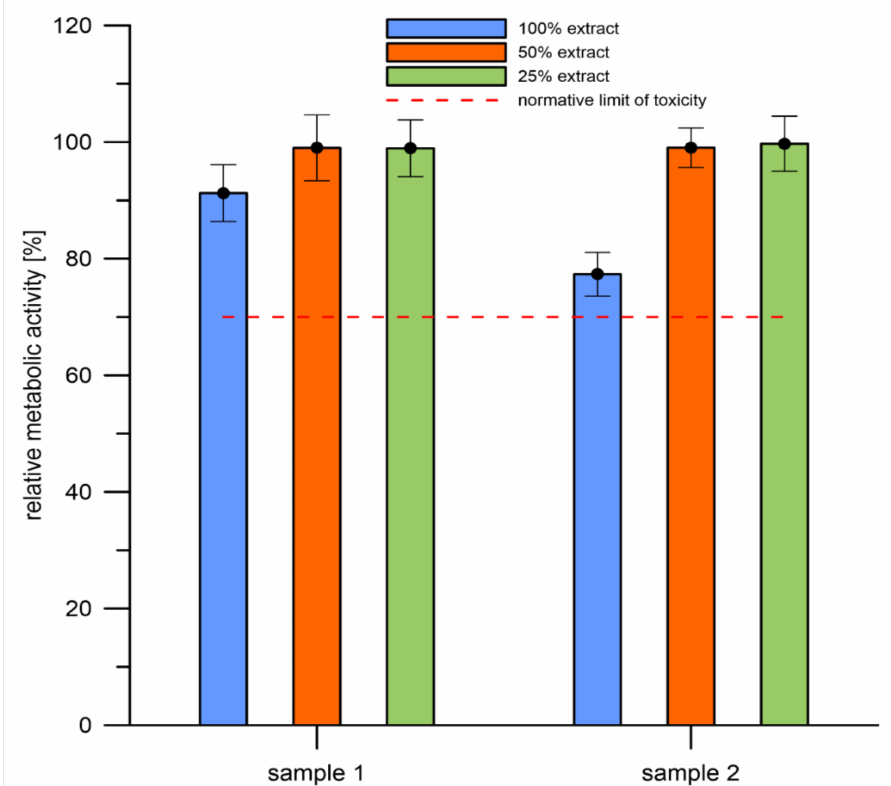
Figure 12. Relative metabolic activity of the L929 cells (resazurin assay) after 1 day incubation with extracts of the samples. Sole extraction medium served as a control (untreated cells, for which metabolic activity was taken as 100%) (sample 1 and sample 2 are 3D-printed